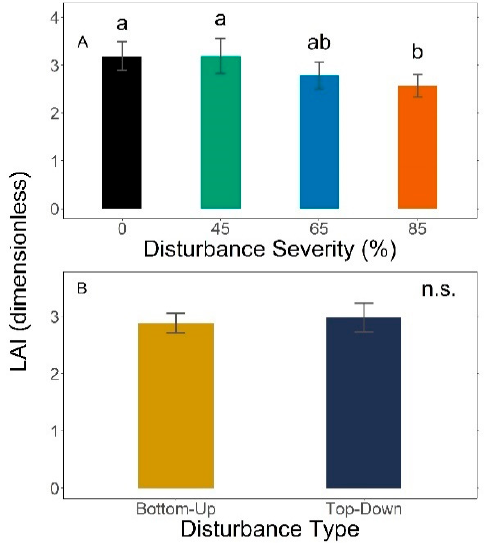
Figure 2. Mean end-of-season (Day of Year 213–215) leaf area index (LAI, ± 1 S.E) by disturbance severity ( A ) and disturbance type ( B ) treatments, three months after phloem-disrupting disturbance. Error bars are the SE of mean leaf area index (LAI) among treatment replicates. Nonoverlapping letters denote significance ( α = 0.05) among disturbance severity treatments. Significant differences between disturbance types were not detected (n.s.).